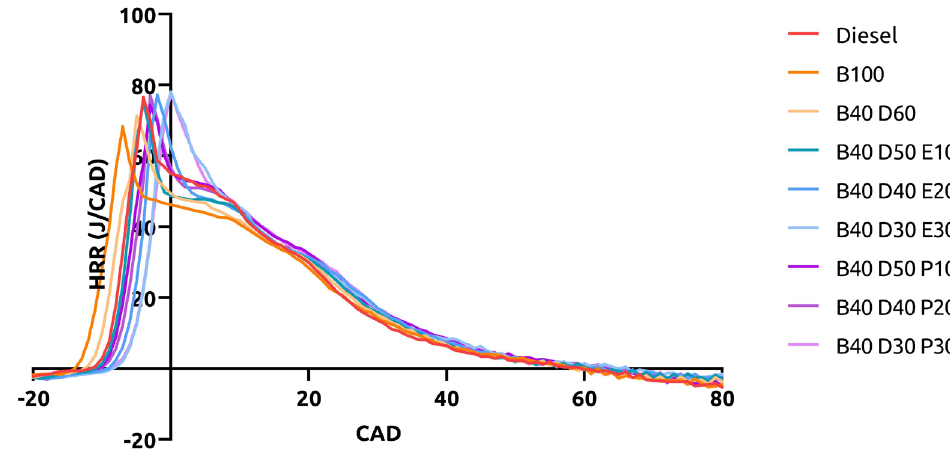
Figure 6. Heat release rate for tested fuels at full engine load.